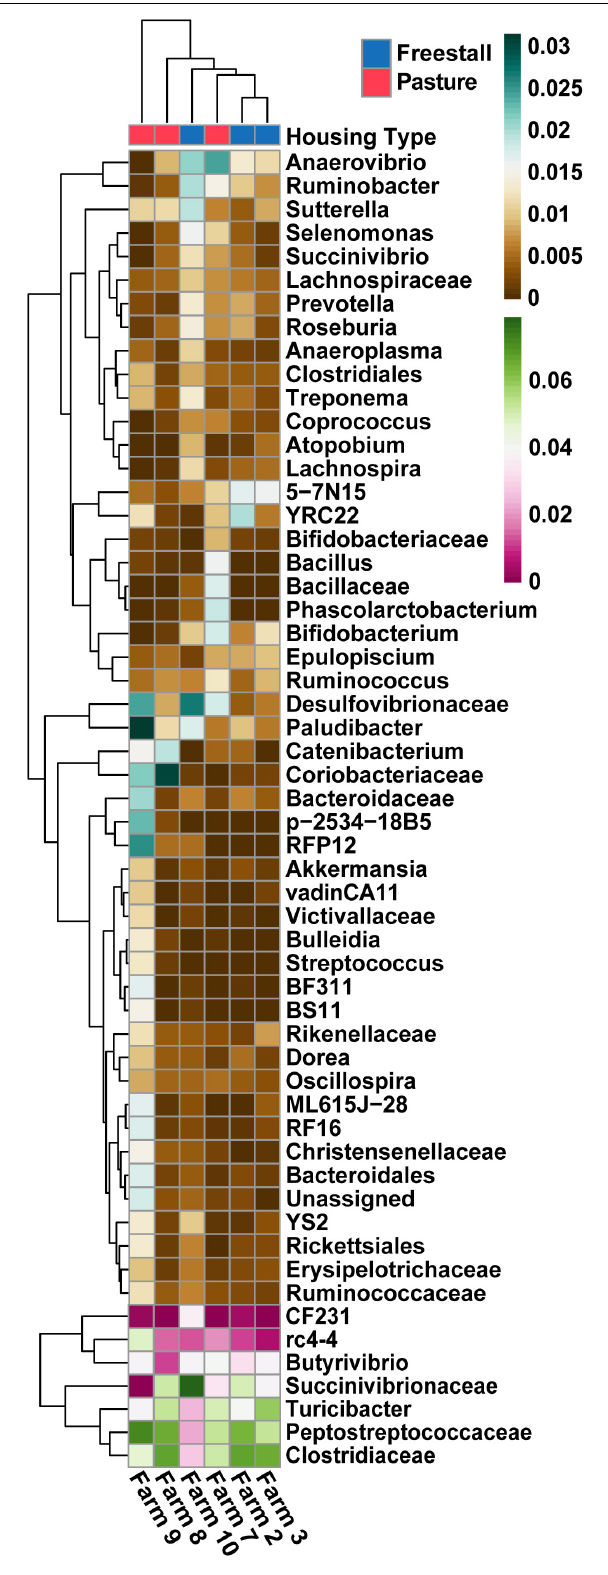
FIGURE 6 | Specific OTUs significantly association with farms ( q > 0.01), as determined by MaAsLin using a subset of farms with complete metadata, are presented. OTUs were collapsed and combined by their lowest assigned taxonomy and plotted by transformed [arcsin(sqrt)] abundance. Hierarchical clustering shows pasture farms are more similar to each other than freestall farms, with the exception of farm 7. Farm 9, an exclusively pasture farm, shows distinct differences from all other farms and has the highest abundance of Coriobacteriaceae